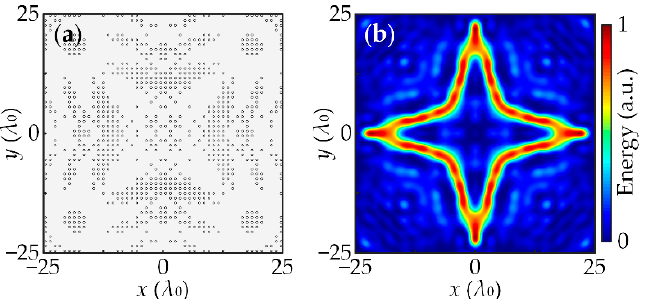
Figure 4. Holographic imaging of an ASM. ( a ) The overall map of the ASM-based hologram based on small holes. The light gray area is the zero-thickness rigid screen and the small circles are the holes with a diameter of d = 0.2 λ 0 ; ( b ) Normalized energy distribution in the image plane calculated by numerical simulation from the hologram shown in ( a ). In the numerical simulation, all of the acoustic and geometric parameters of the holographic imaging system based on the ASM are the same as those of the holographic imaging system based on the PS array.